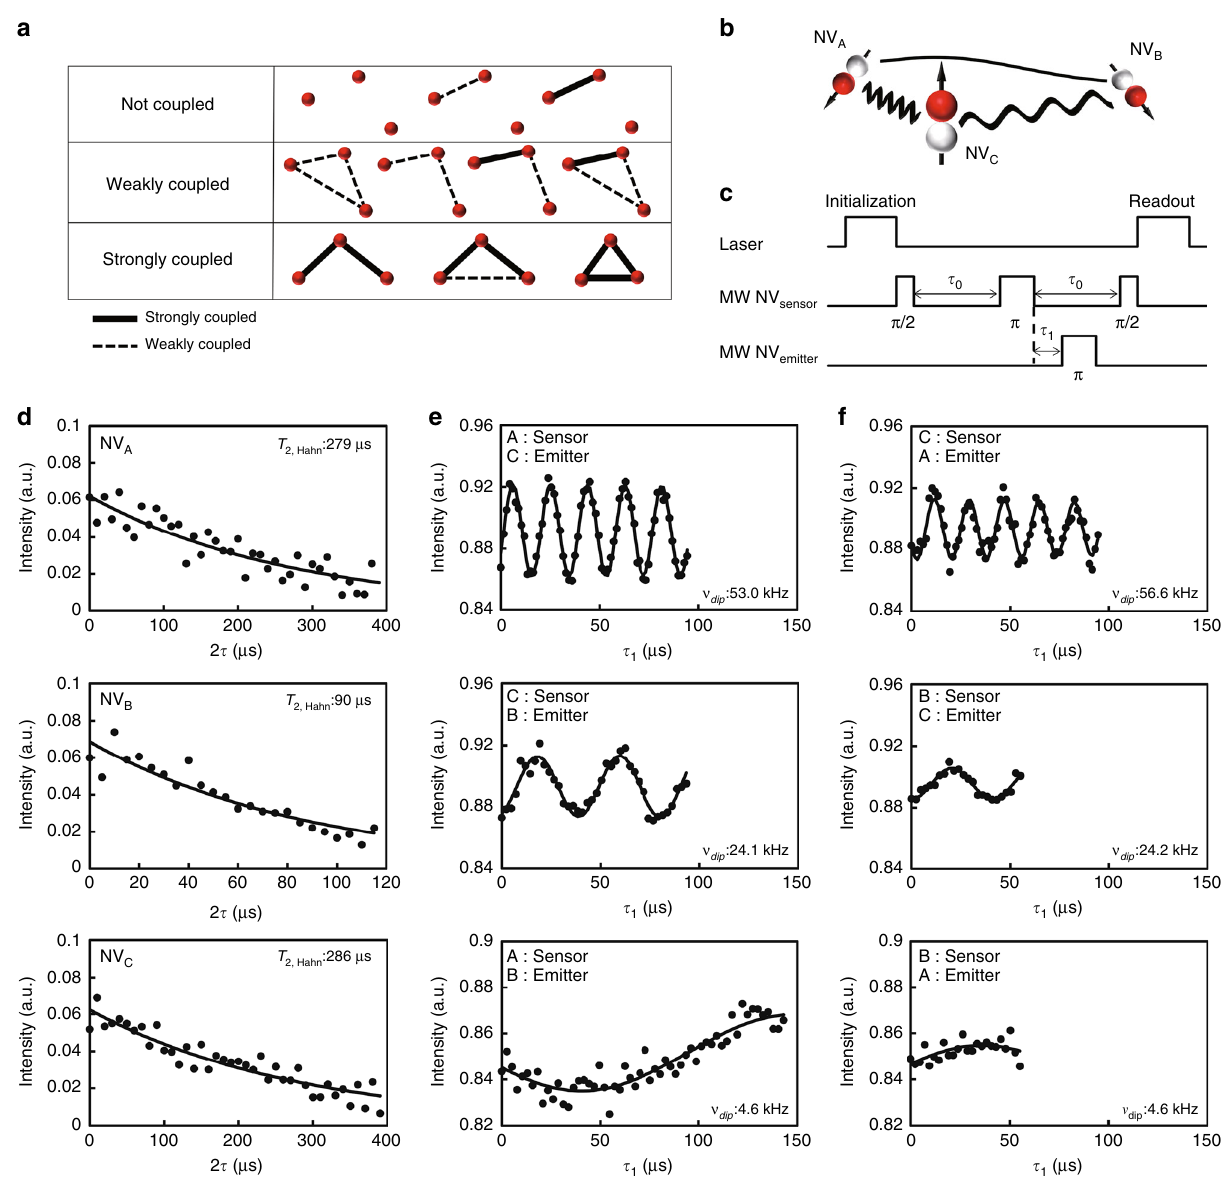
Fig. 3 Coherence times and DEER of triple NV centre. a Classi fi cation of triple NV centres. b Schematic diagram of evaluated triple NV centres. c Pulse sequence in DEER measurements. d Hahn echo decay curves for NV A , NV B , and NV C . The closed circles represent the experimental echo data and the solid lines show the exponential fi tting curves. The T 2,Hahn values for NV A, NV B , and NV C were evaluated to be 279, 90, and 286 μ s, respectively. e DEER measurements results signal of NV A – NV C , NV C – NV B , and NV A – NV B , when NV A , NV C , NV A were used as sensor. Closed circles represent the DEER data and solid lines show the fi tting curves. The ν dip of these pairs were evaluated to be 53.0, 24.1, and 4.6 kHz, respectively. f The DEER measurement results signal of NV C – NV A , NV B – NV C , and NV B – NV A , when NV C , NV B , NV B were used as the sensor, respectively. Similar ν dip values of 56.6, 24.2, and 4.6